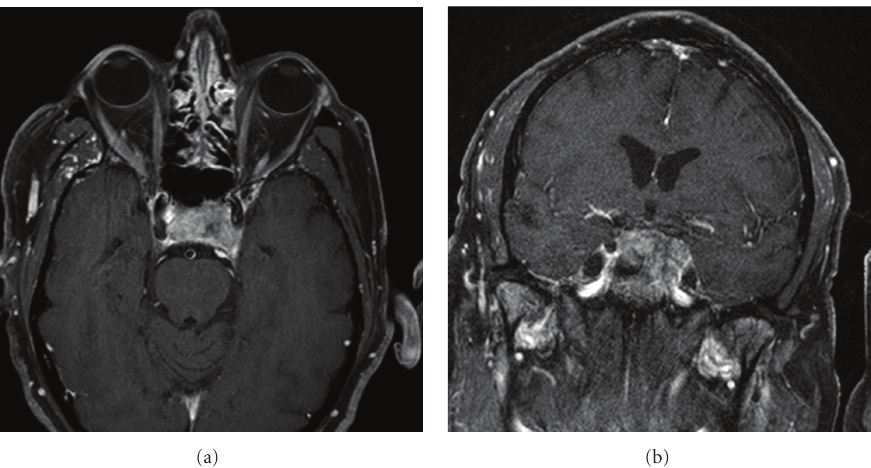
Figure 1: Axial and coronal T1-weighted MR imaging of the brain with gadolinium enhancement showing a heterogeneously enhancing mass involving the sella with invasion into the left cavernous sinus and the superior clivus.